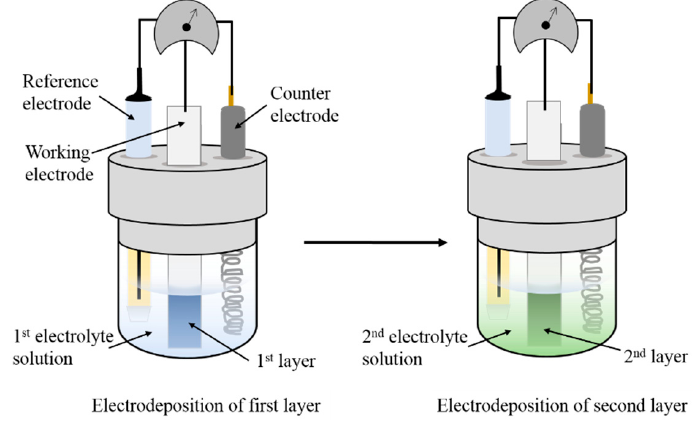
Figure 9. Simple electrodeposition LBL assembly.